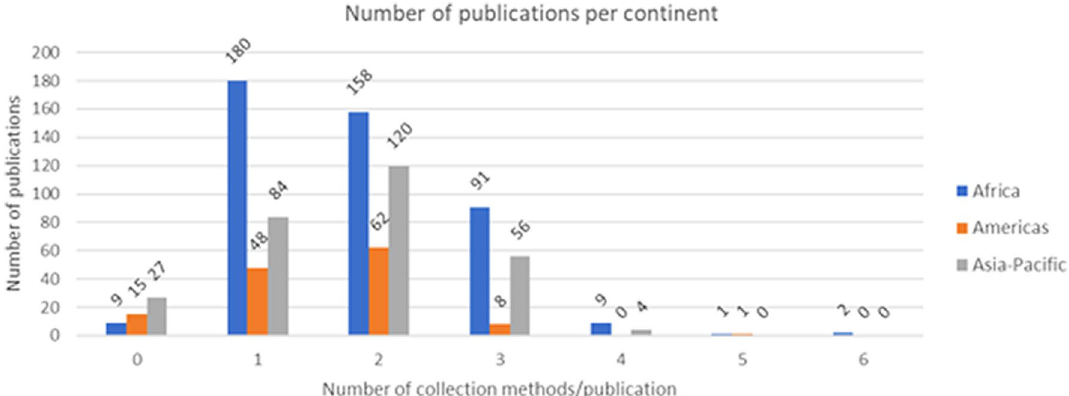
Figure 1. Number of publications per continent. For each continent, the number of publications is shown, as well as the number of collection methods that were reported in each publication. Zero collection methods used means that there was no specific information available about the type of collection method(s) used in a